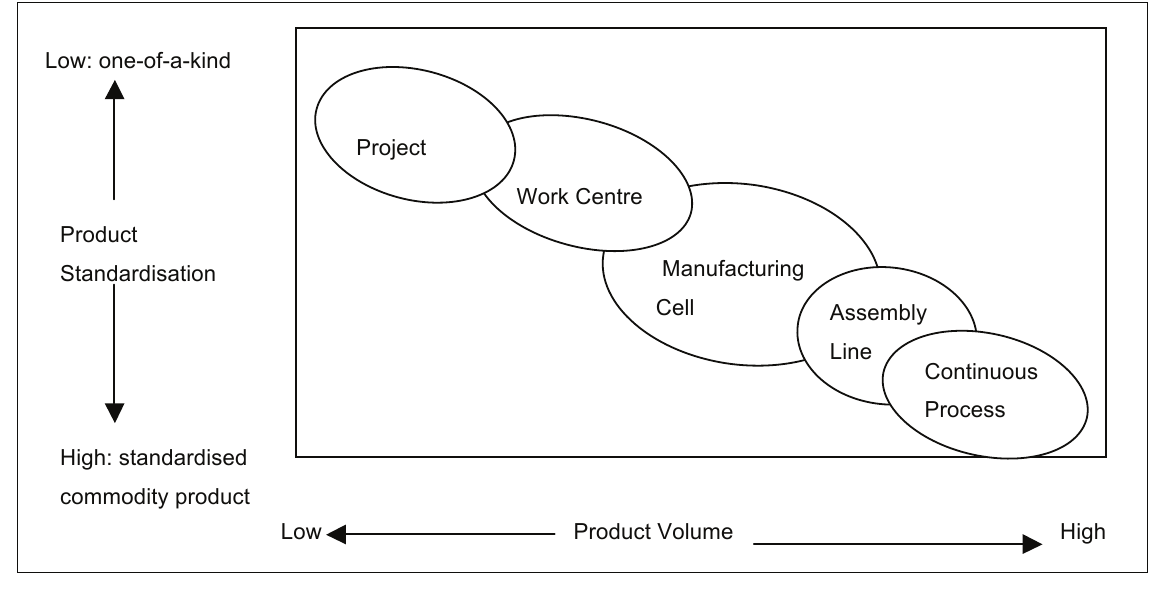
Figure 1: Supply chain strategies linked to the product life cycle Source: Chibba (2007); Astrom and Ohgren (2010:22); Qi et al. (2009:670)